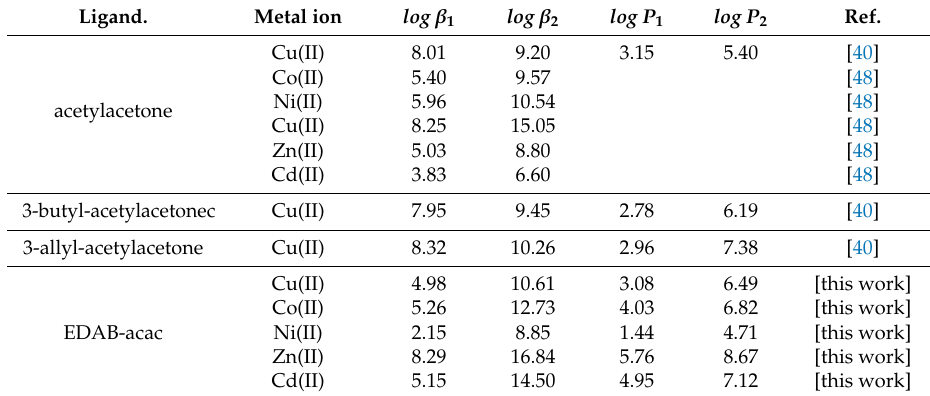
Table 2. Comparison of the stability constants β n of M(II) complexes with EDBA-acac, acac, and acac-alkyl derivatives and at 25 ◦ C.